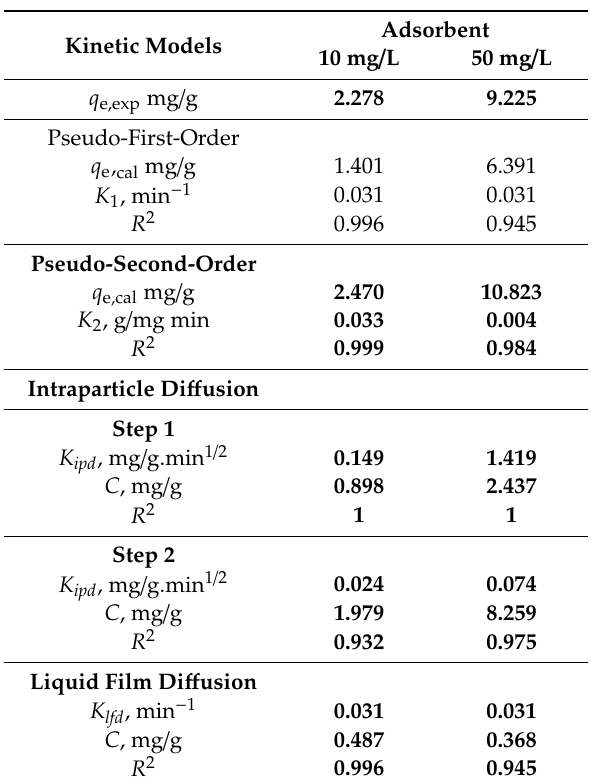
Table 1. Parameters of four kinetic